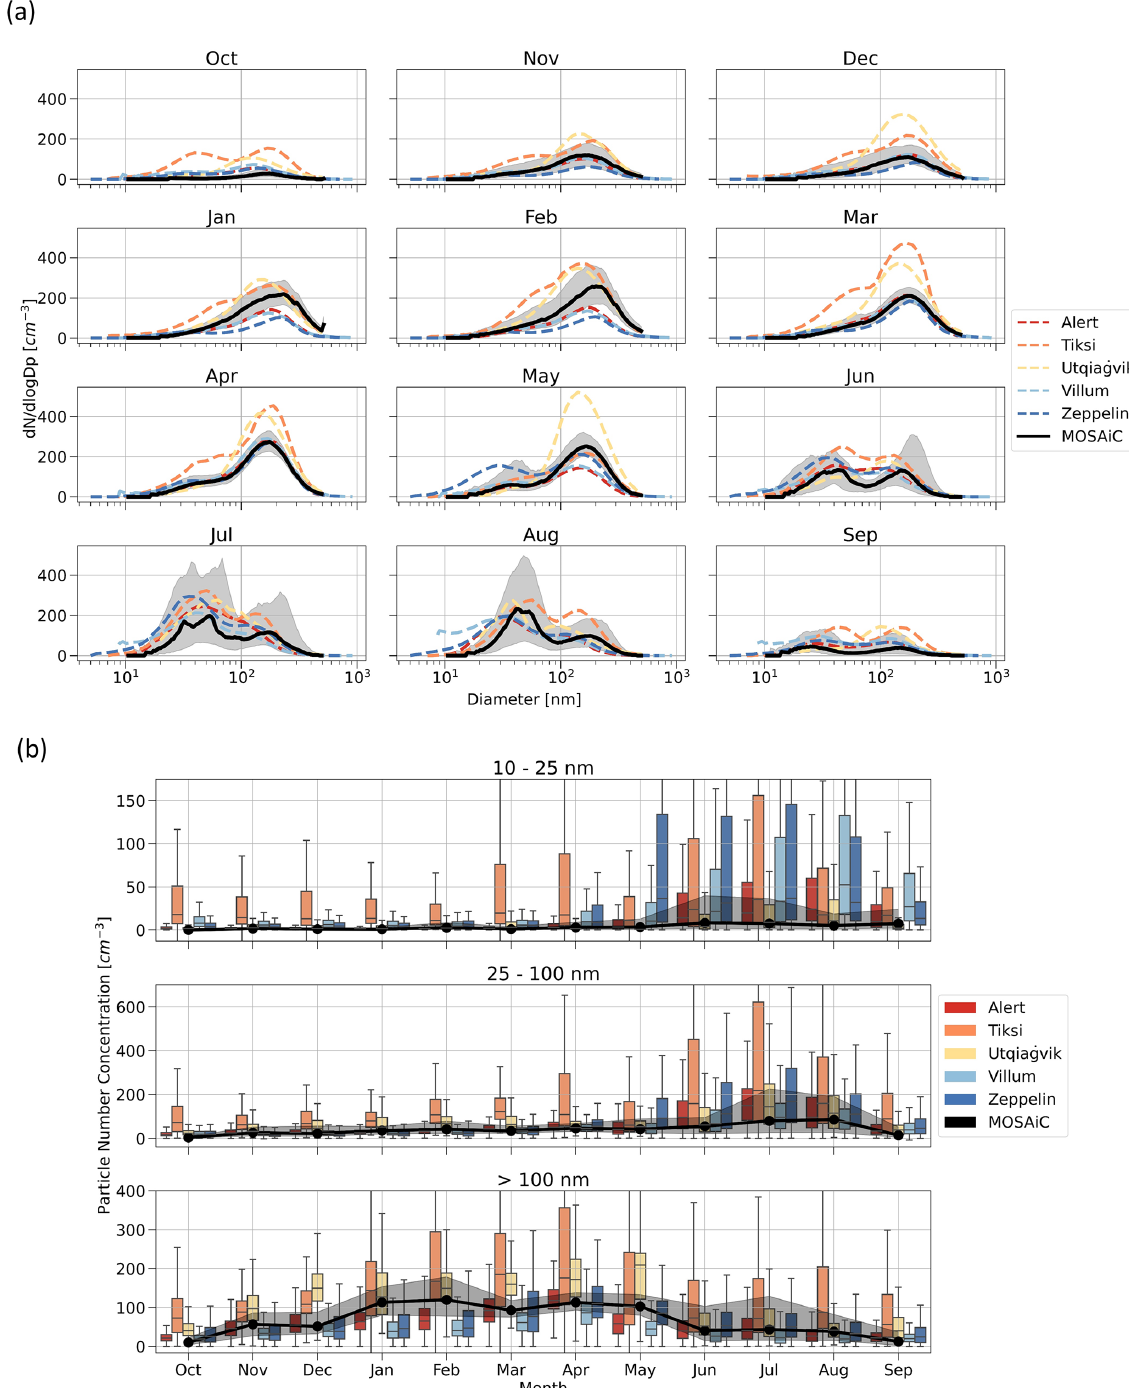
Figure 9. Comparison of (a) PNSD and (b) PNC between MOSAiC and the long-term record of aerosol observations from land-based sites across the Arctic. (a) The PNSD data for all the sites are presented as monthly median values, and the shaded region indicates the interquartile range of the PNSD data from the MOSAiC campaign. (b) The box plots show the median monthly PNC and interquartile range at each site, where the particle concentrations are separated into three size modes (particle diameters of 10–25, 25–100, and > 100nm). The MOSAiC data are presented as the solid black line, where the shaded region represents the interquartile range. The data from the land-based sites span several decades, where the timespan varies depending on the site (Alert: 2011–2018, Tiksi: 2010–2018, Utqia˙gvik: 2007–2015,